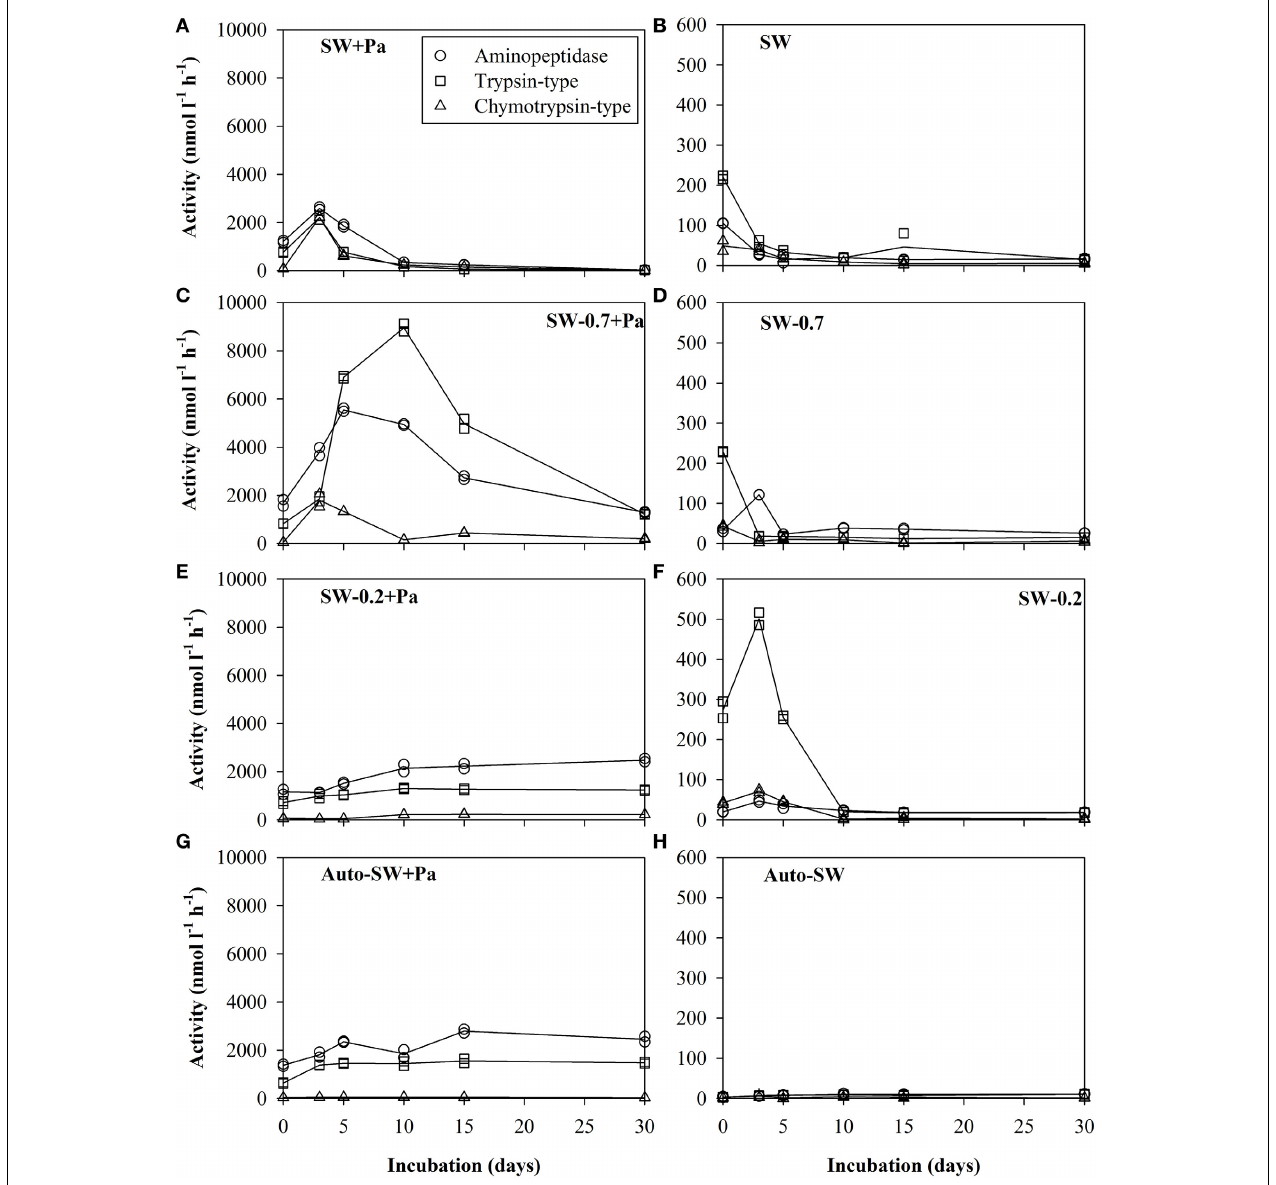
FIGURE 3 | Proteolytic activity in the (A) SW + Pa, (B) SW, (C) SW-0.7 + Pa, (D) SW, (E) SW-0.2 + Pa, (F) SW-0.2, (G) Auto-SW + Pa, and (H) Auto-SW microcosms over the course of the study. Solid lines show the average of duplicate measurements and plots are of data obtained from duplicate samples. Left panels are microcosms with addition